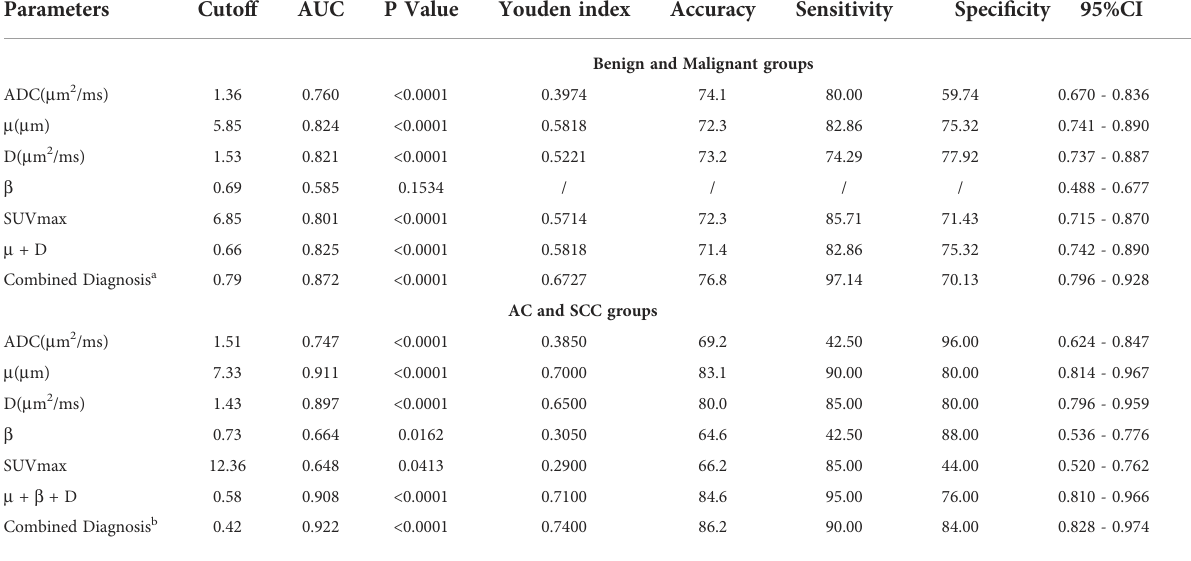
TABLE 5 ROC analysis of the diagnostic performance for different parameters and methods alone or in combination for distinguishing benign and malignant groups, and distinguishing AC and SCC groups. Parameters Cutoff AUC P Value Youden index Accuracy Sensitivity Speci fi city